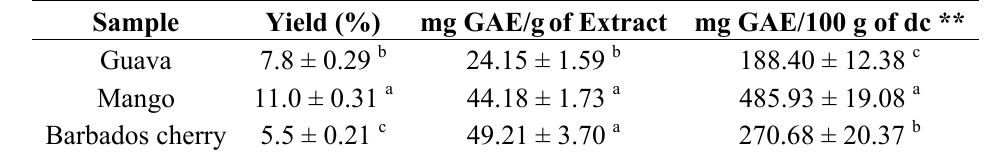
Table 1. Yield of extracts and total extractable phenolic content (TEP) of fruits co-products